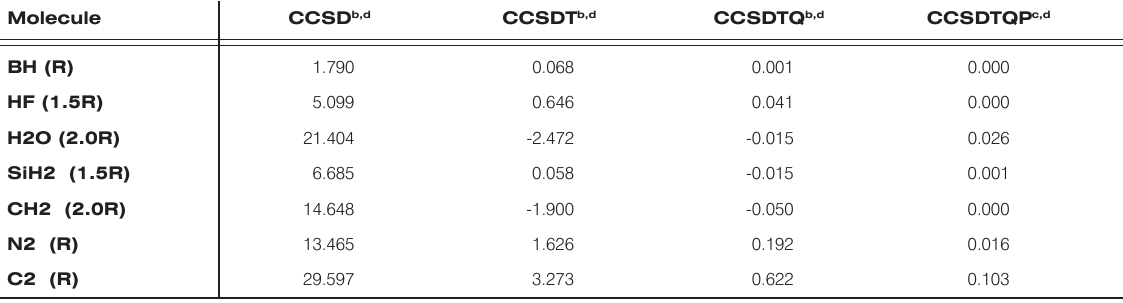
Table 3. Correlation corrections (in mH) with various coupled cluster methods relative to full configuration interaction a values.